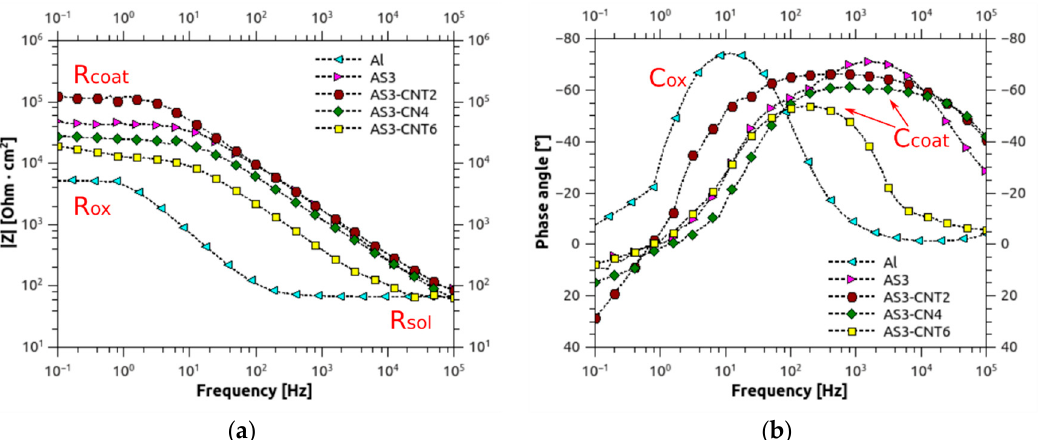
Figure 7. Bode plot of impedance modulus ( a ) and phase angle ( b ) of CNT filled and unfilled silane coating after 0 h of immersion in NaCl 3.5 wt.% solution.